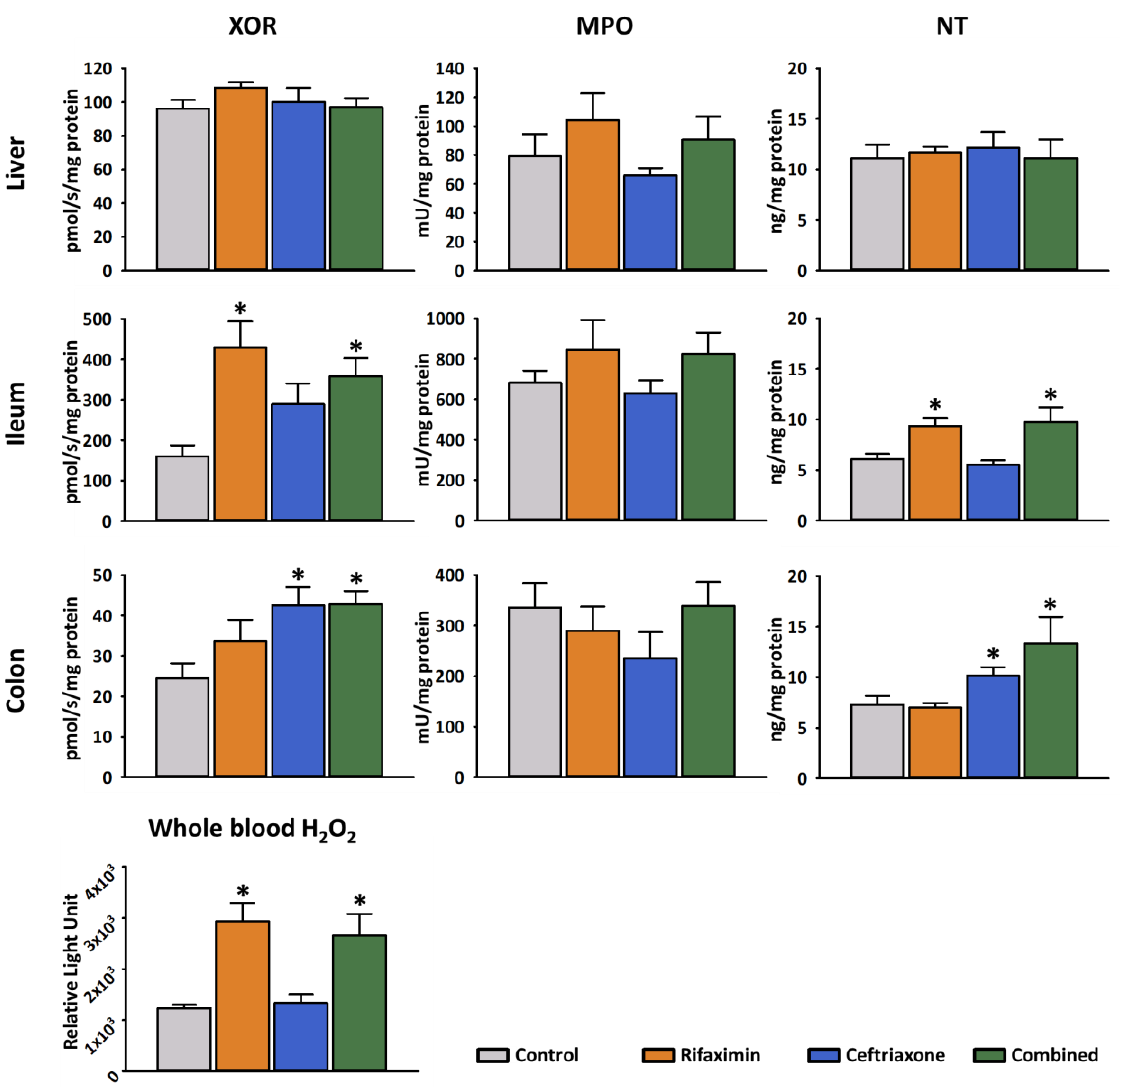
Figure 3. Oxido-reductive stress markers in different tissues following systemic antibiotic treatment. Tissue xanthine oxidoreductase (XOR) activity, myeloperoxidase (MPO) activity and nitrotyrosine (NT) levels were measured in the liver, the terminal ileum and the distal colon, and whole blood hydrogen-peroxide (H 2 O 2 ) production was determined following 3 days of antibiotic treatment. Orange columns: Rifaximin treatment; Blue columns: Ceftriaxone treatment; Green columns: combined treatment. Data are presented as mean ± SEM. * p < 0.05 vs. control (one-way ANOVA, Holm–Sidak test) are considered as significant. Table 1. Serum necroenzyme levels. Aspartate-aminotransferase (AST), alanine-aminotransferase (ALT) and lactate-dehydrogenase (LDH) expressed in U/L. Data are presented as mean ± SEM. * p < 0.05 vs. control (one-way ANOVA, Holm – Sidak test) are considered as significant. AST